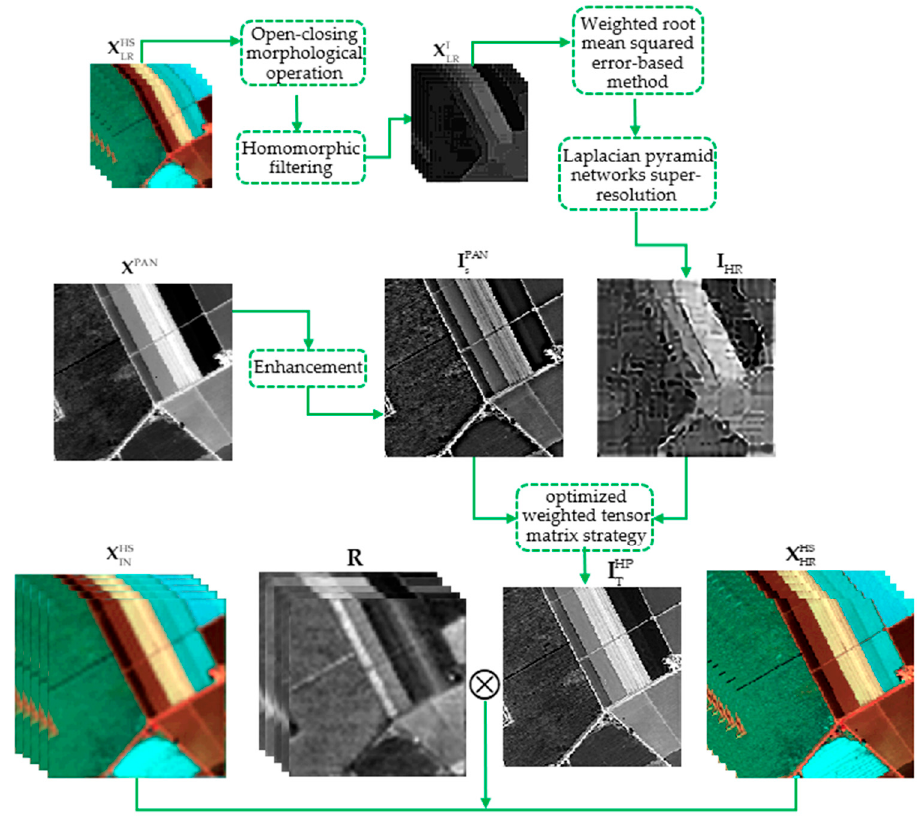
Figure 2. Schematic of the proposed homomorphic filtering and weighted tensor (HFWT) matrix-based hyperspectral pansharpening algorithm.